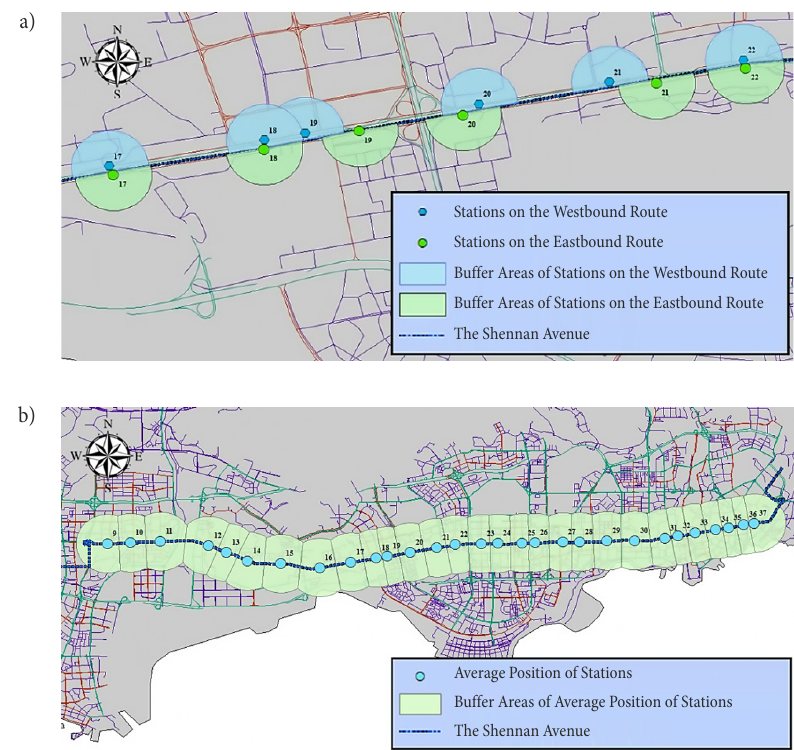
Figure 1. Buffer areas to capture: a – pick-up behavior of taxis; b – drop-off behavior of